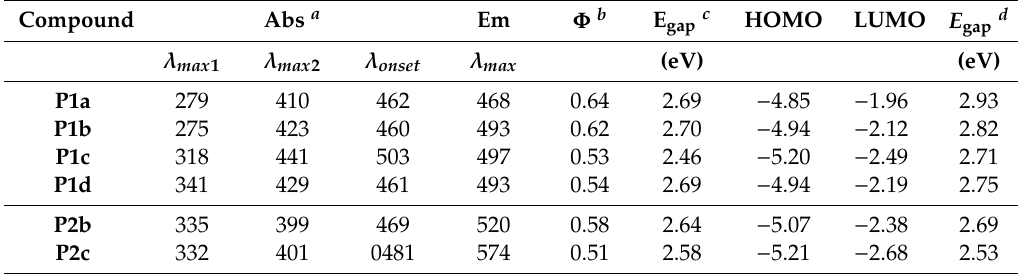
Figure 2. Density functional theory (DFT)-calculated frontier molecular orbitals (M06HF / 6-31G** level) for M1a , M1b , and M2b monomers ( A ) and P1a and P1b tetramers ( B ), P2b tetramers ( C ). The molecular orbitals for the rest of the copolymers are given in the supporting information. Table 2. Photophysical measurement and theoretical data obtained for P1 and P2